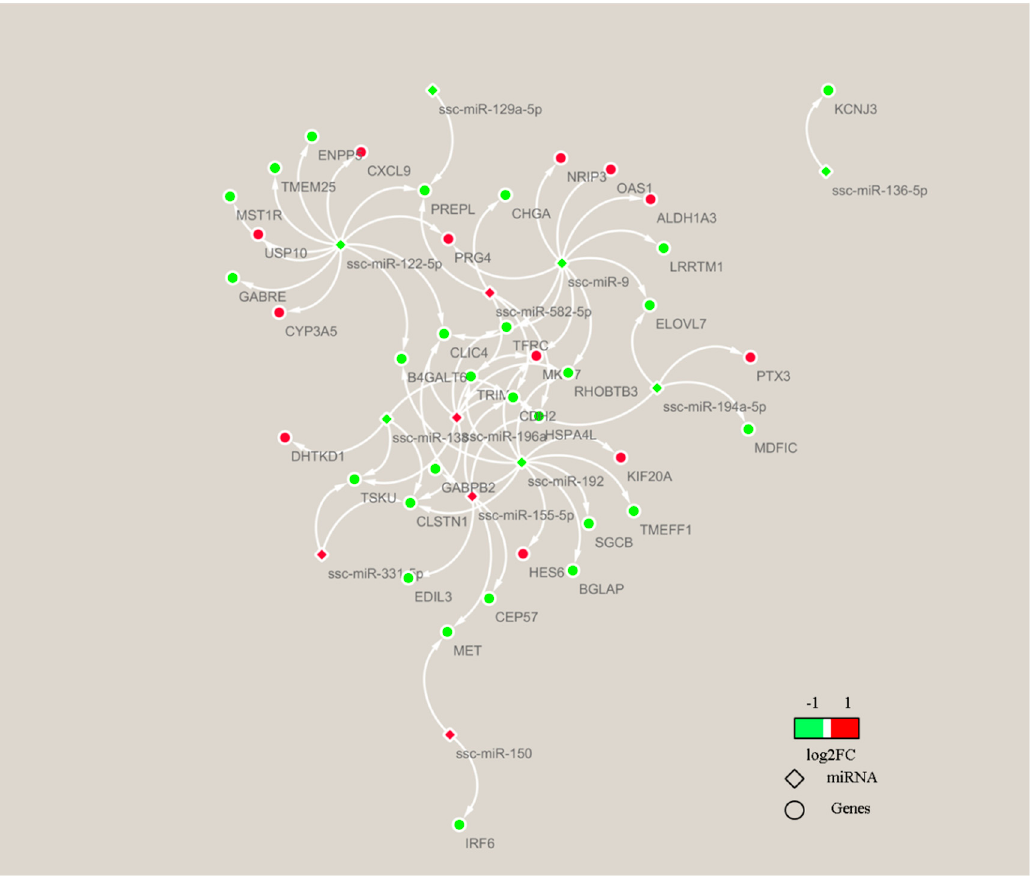
Figure 8. DEMs–target mRNA interaction network. The network of 11 DEMs and 39 target genes of miRNA were analyzed using Cytoscape.